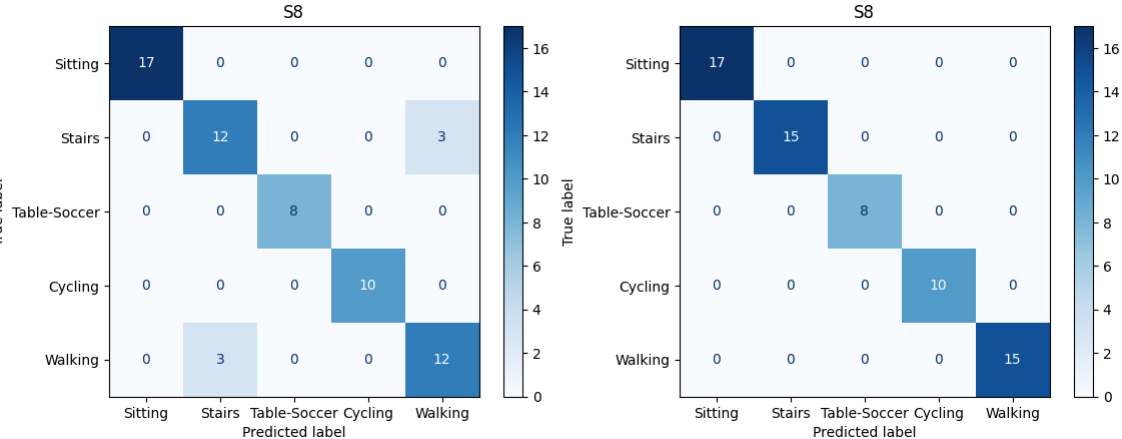
Figure 9. Comparison between confusion matrices in subject-specific models. On the left : the model performance when considering only 3D-ACC. On the right : the model performance when combining 3D-ACC with the ECG